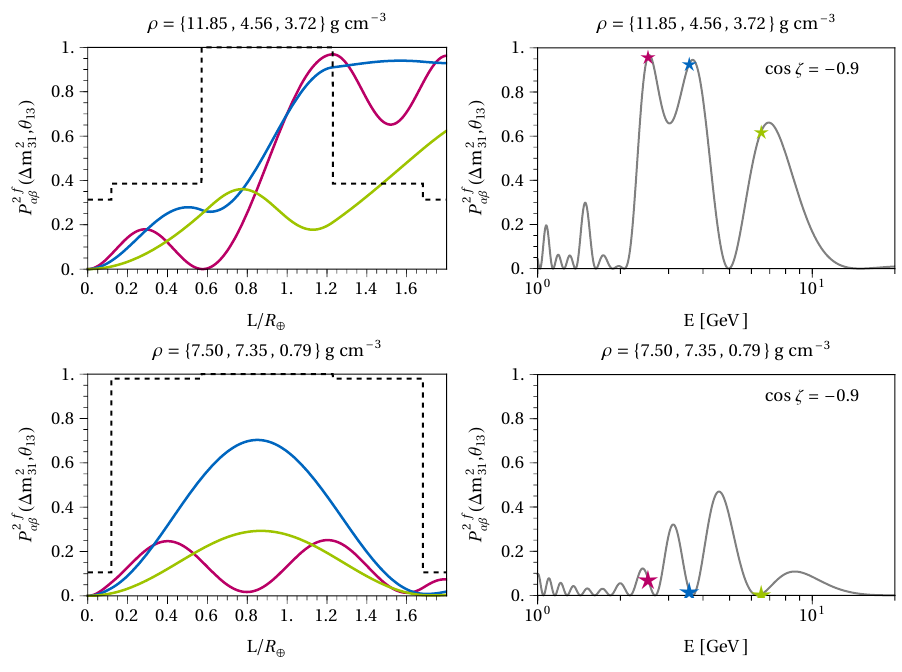
Figure 6 . Similar to figure 5, but considering atmospheric parameters